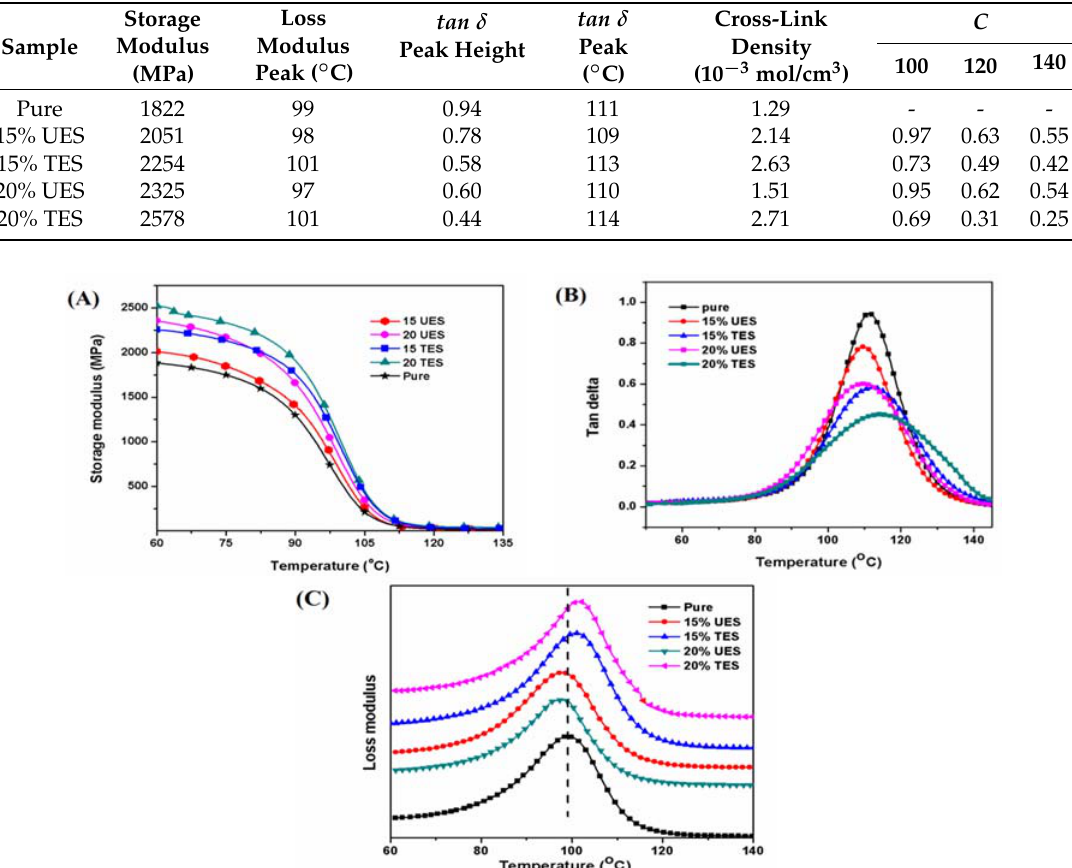
Table 5. DMA data and effectiveness coefficient C of neat epoxy; UES and TES filled epoxy composite.